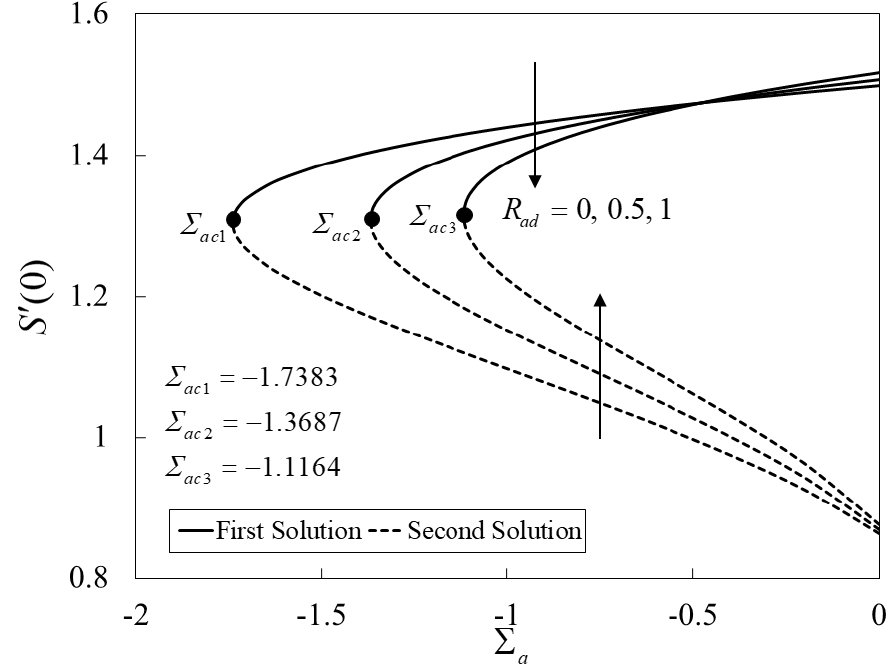
Figure 7. Variation in the local Sherwood number   ' 0 S with  a for different values of ad R .